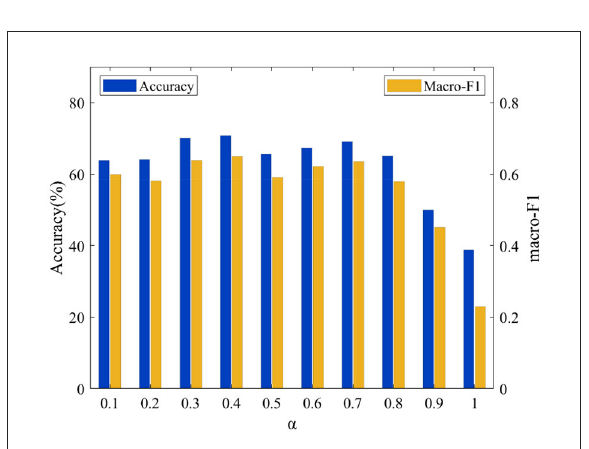
FIGURE7 Acc and macro F1 for different α on the LTM_108 dataset.